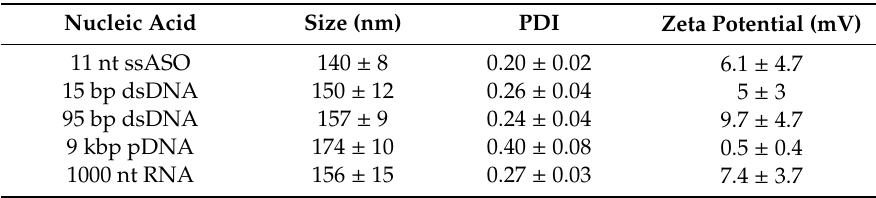
Table 2. Size and zeta potential of LPN.